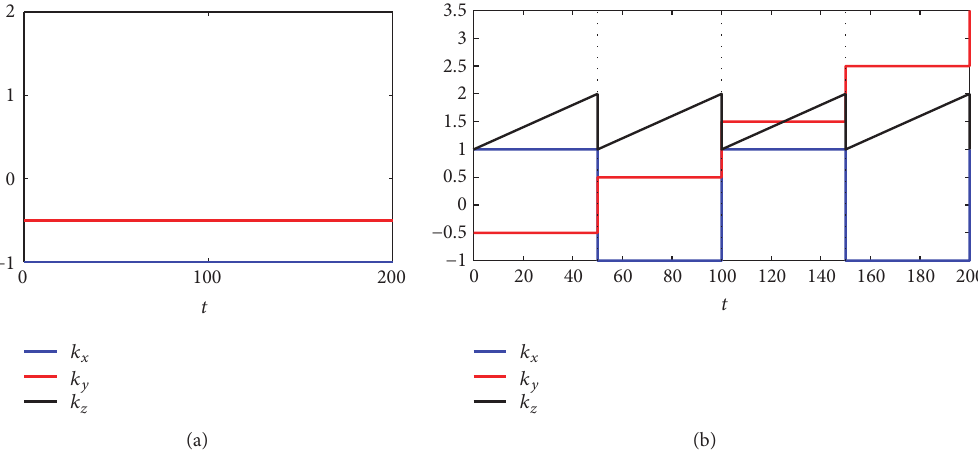
Figure 6: (a) Static scaling factors 𝑘 𝑥 = −1 , 𝑘 𝑦 = −0.5 , and 𝑘 𝑧 = 2 and (b) dynamic scaling factors 𝑘 𝑥 = (−1) int (𝑡/50) , 𝑘 𝑦 = −0.5 + int (𝑡/50) , and 𝑘 𝑧 = 1 + ( mod (𝑡/50))/50 versus